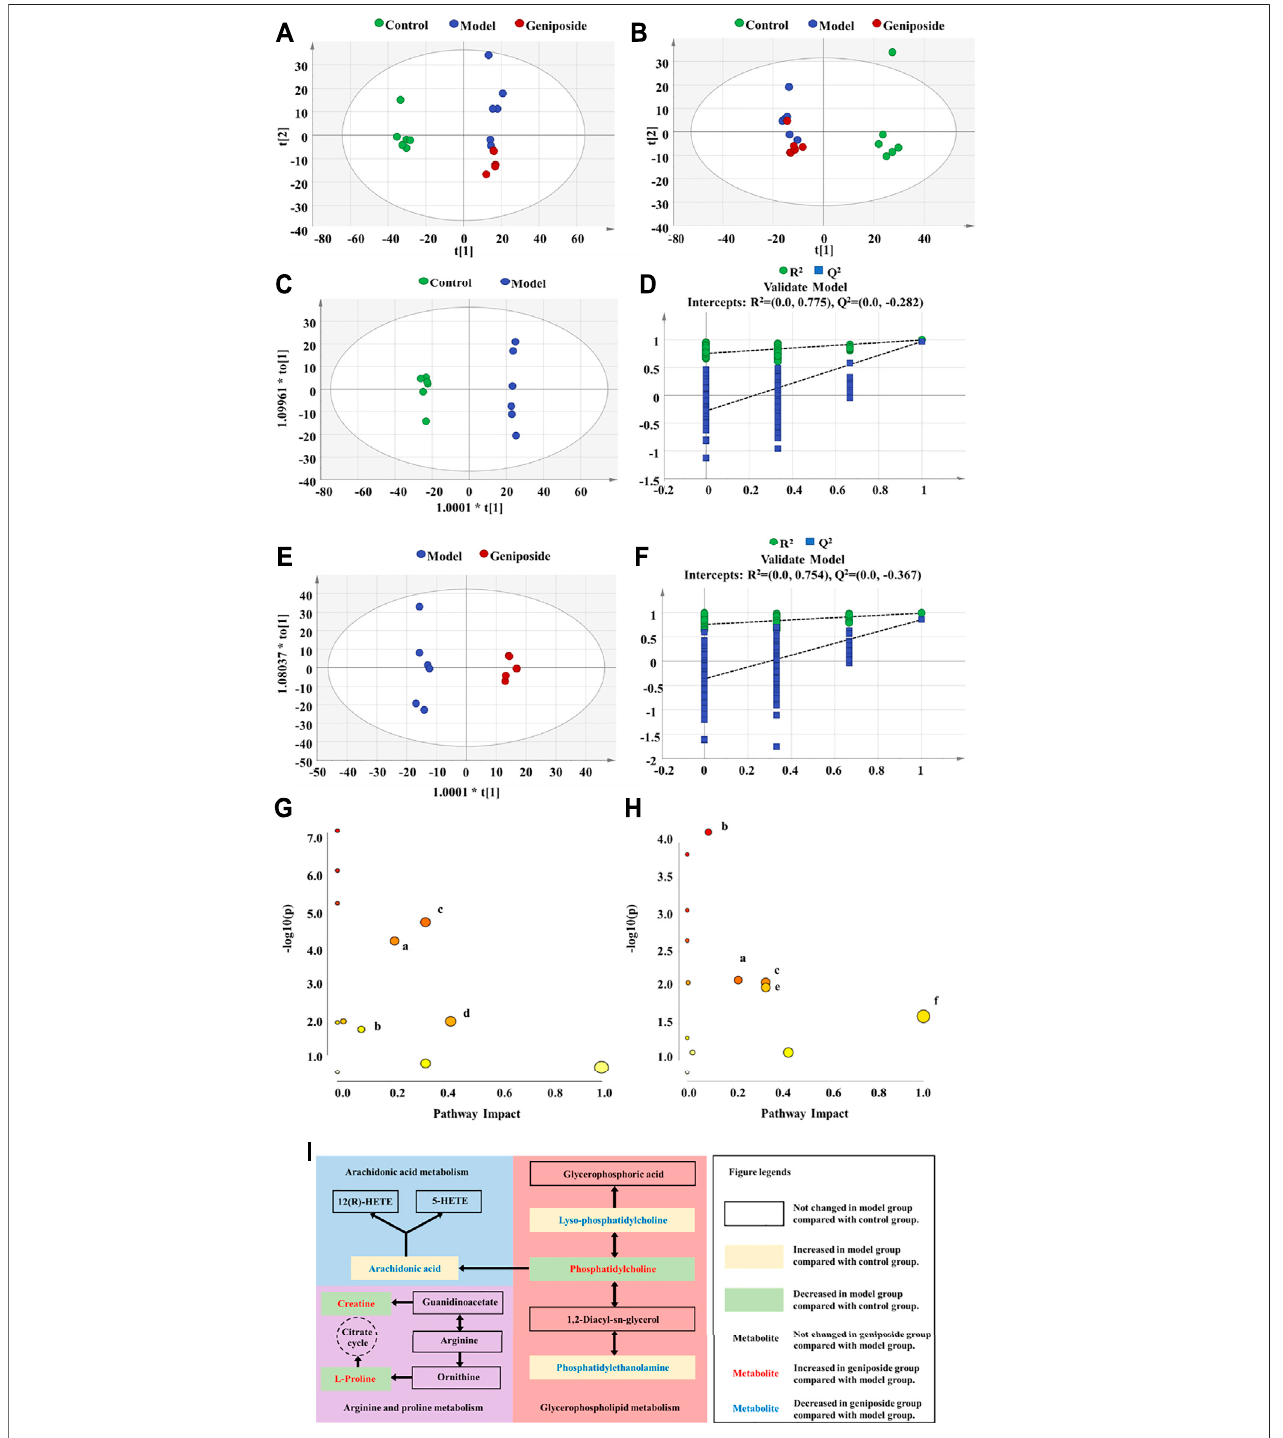
FIGURE 7| Serum metabolism analysis of geniposide in liver fi brosis. (A) PCA score plot among control, model, and geniposide groups in positive mode. (B) PCA score plot among control, model, and geniposide groups in negative mode. (C,D) OPLS-DA score plot among control and model groups and the corresponding coef fi cient of loading plots. (E,F) OPLS-DA score plot among model and geniposide groups and the corresponding coef fi cient of loading plots. (G) Pathway analysis between control and model groups. (H) Pathway analysis between model and geniposide groups. (a) Glycerophospholipid metabolism, (b) Arginine and proline metabolism, (c) AA metabolism, (d) Taurine and hypotaurine metabolism, (e) alpha-Linolenic acid metabolism, and (f) Linoleic acid metabolism. Control, model, and geniposide treated groups ( n (cid:2) 6 per group). #: p < 0.05 and ## p < 0.01, Model group vs. Control group; p p < 0.05 and pp p < 0.01, Geniposide group vs. Model group.